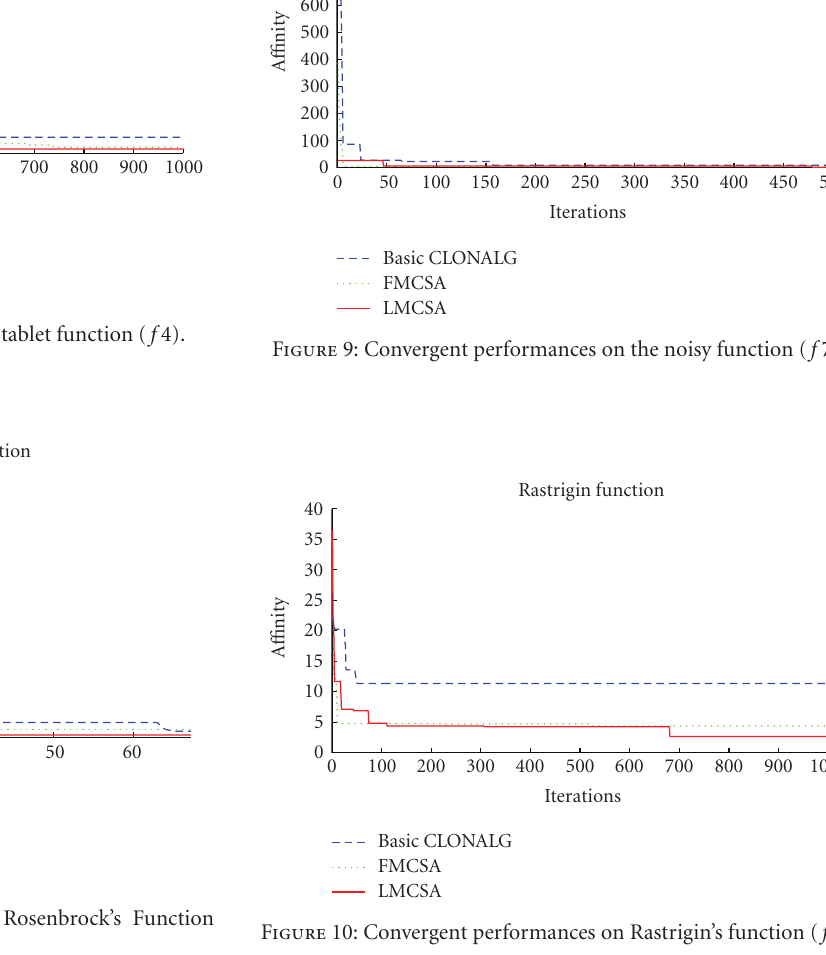
Figure 10: Convergent performances on Rastrigin’s function ( f 8).